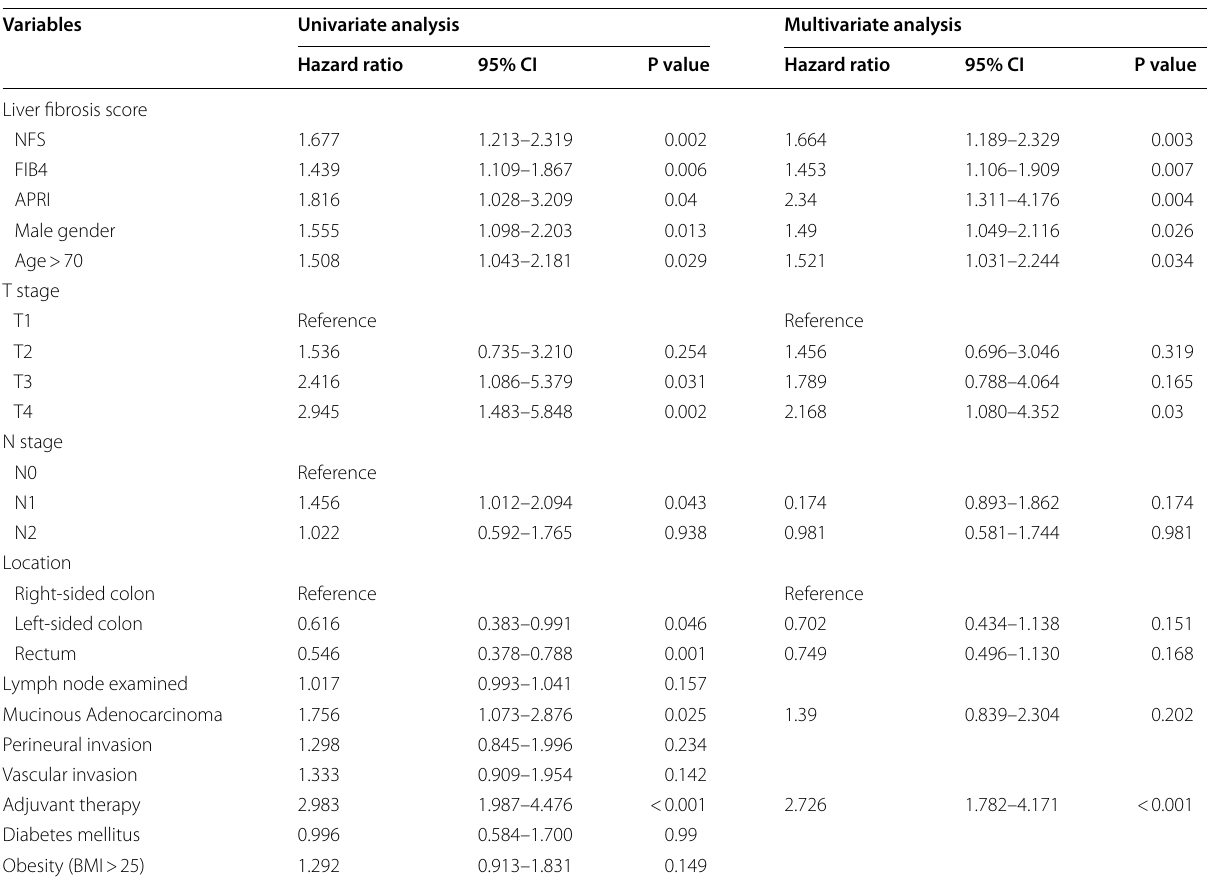
Table 3 Risk factors for any hepatic metastasis postoperatively